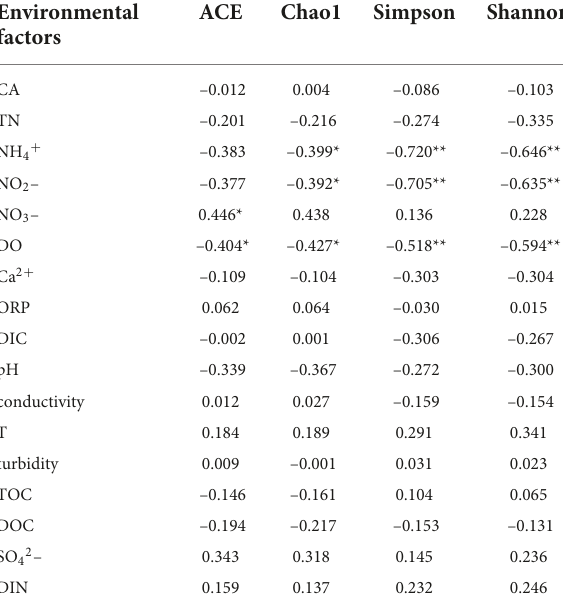
TABLE 4 Results of the correlation analysis between the community diversity of the cbbL gene-containing carbon-fixing bacteria and environmental factors in the Huixian karst groundwaters.